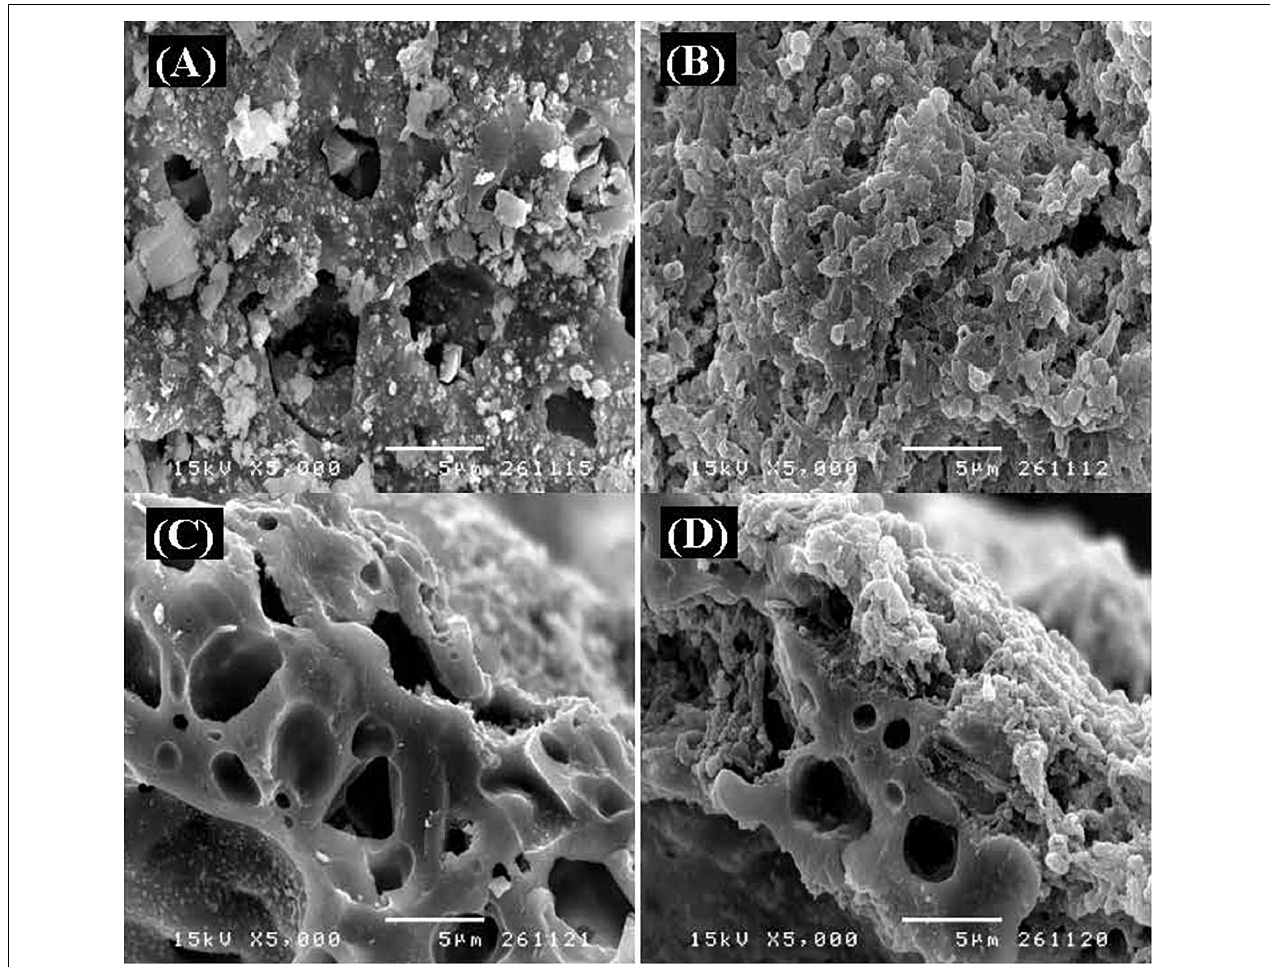
FIGURE 4 | Scanning electron microscope studies of (A) the surface of expanded clay, (B) a biofilm on the expanded clay at the end of a long-term operation experiment, (C) a cross-section of the expanded clay, and (D) a cross-section of the biofilm on expanded clay at the end of a long-term operation experiment. Images at × 5,000 magnification were obtained using a JSM-5410LV electron microscope operating at 15 kV.